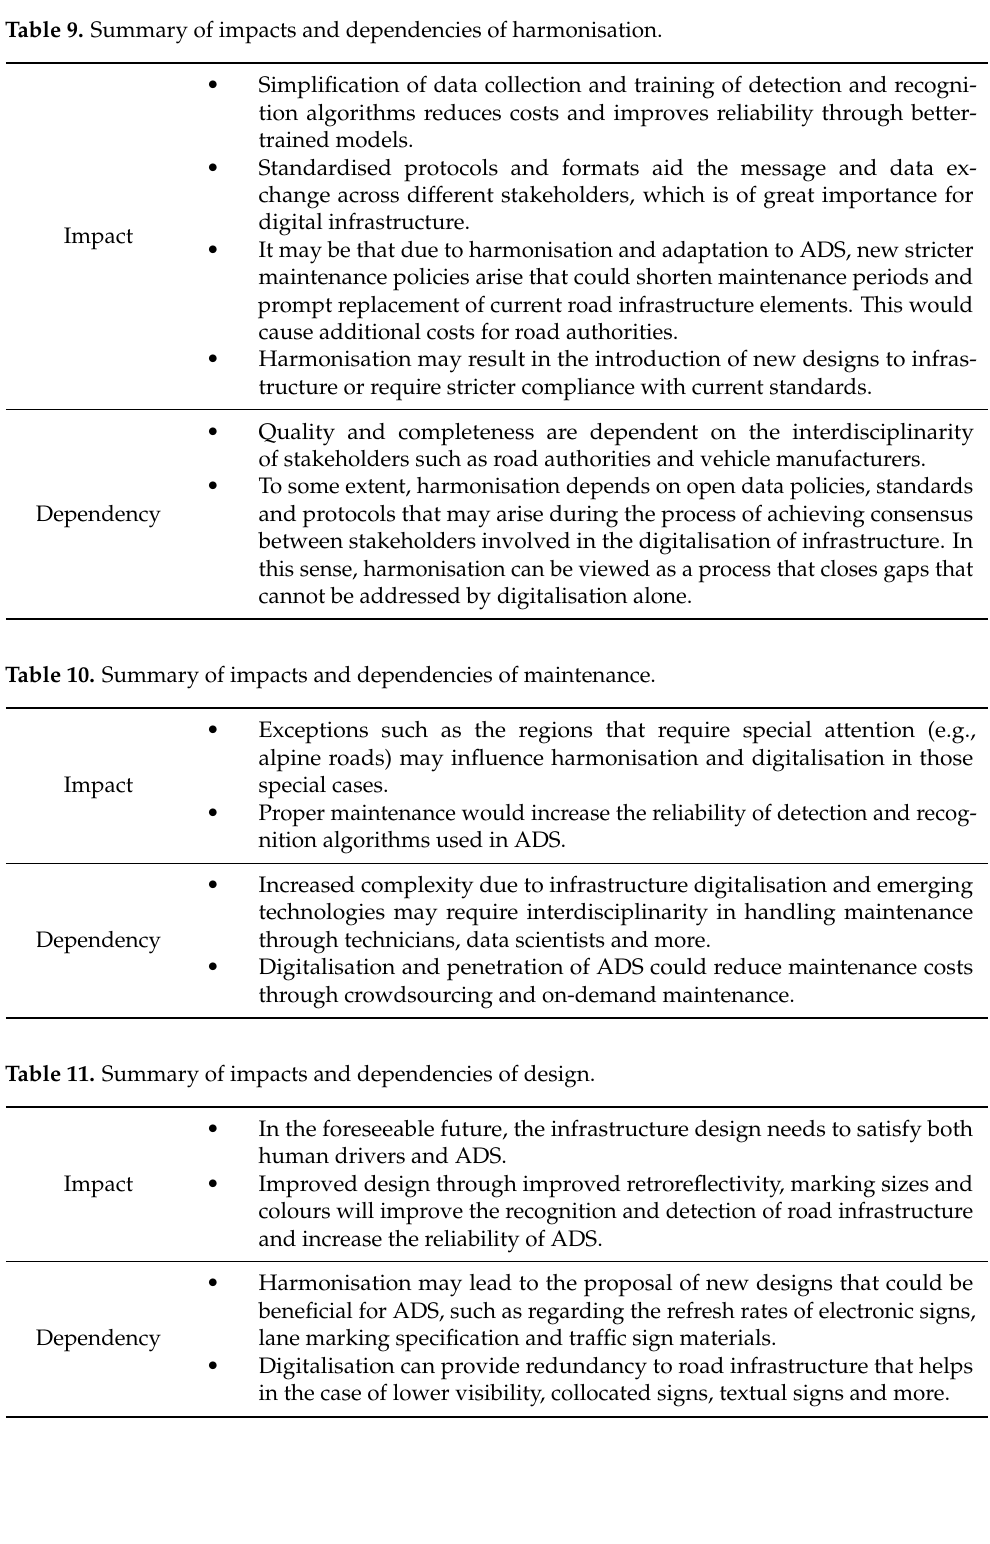
Table 9. Summary of impacts and dependencies of harmonisation.